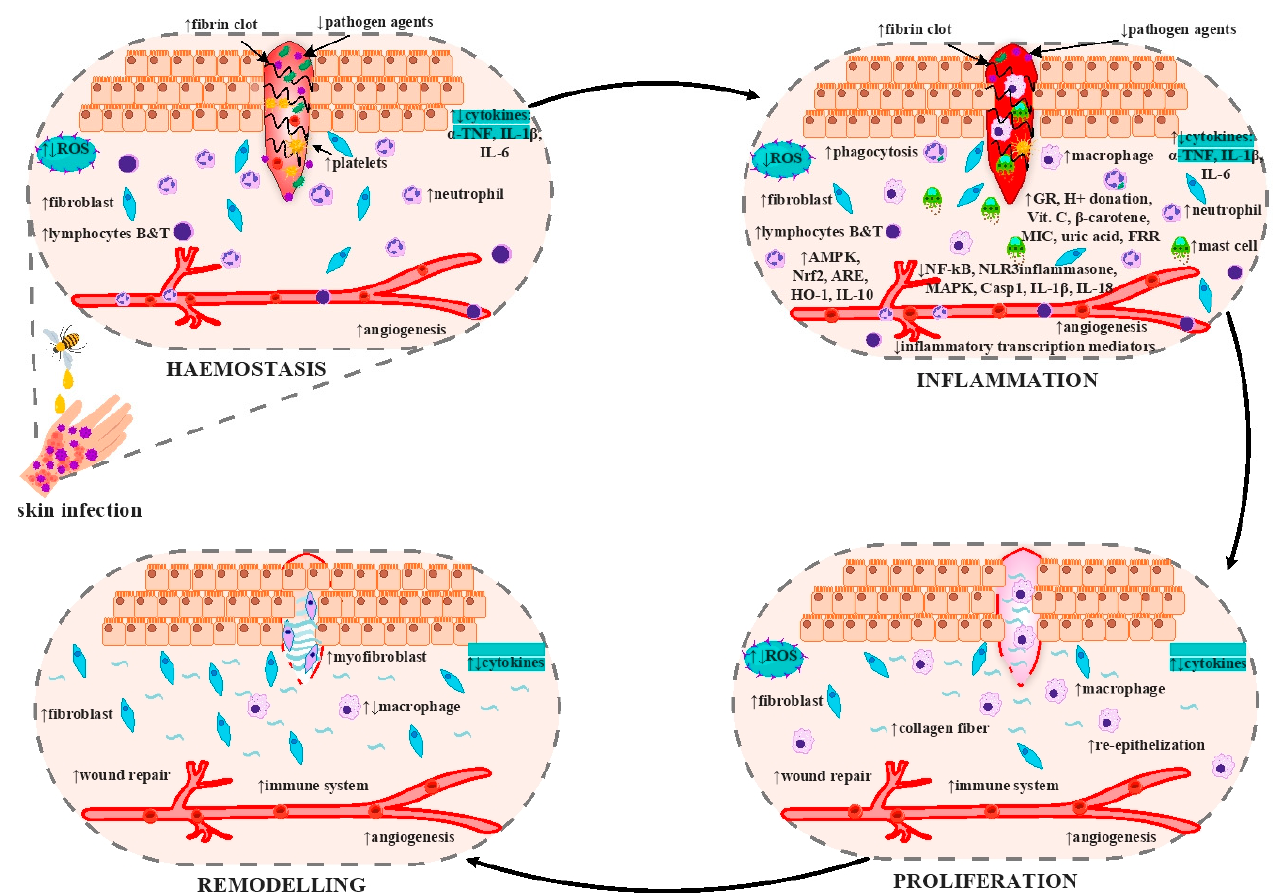
Figure 6. Potential of honey as a wound healing agent. The figure was designed with ConceptDraw Diagram 16. “ ↑ ”-high and “ ↓ ”-low